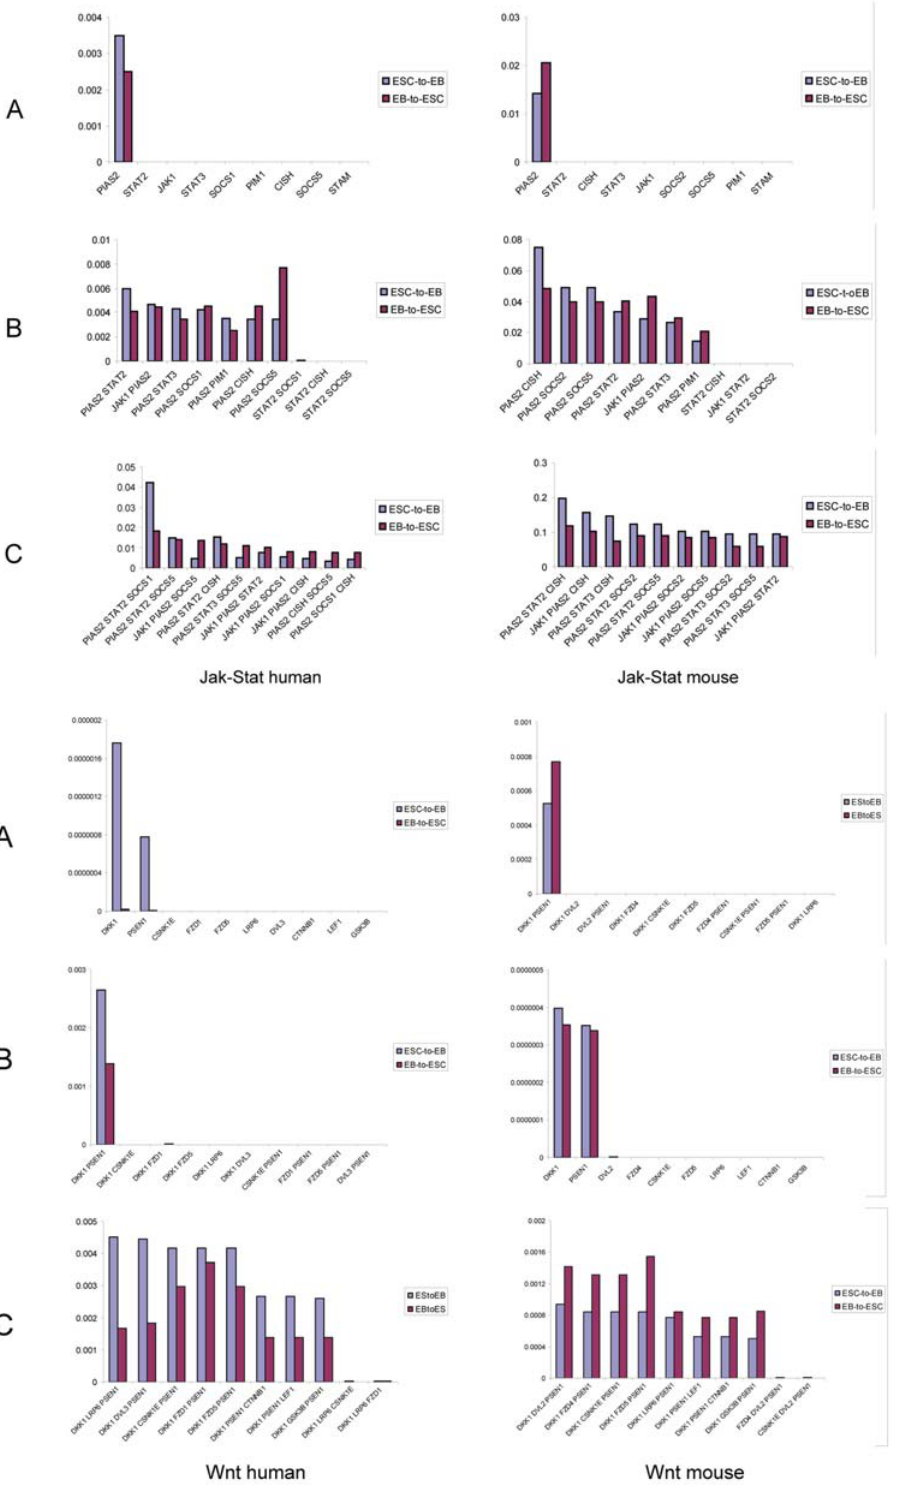
Figure 3. Probabilities of pathway behavior transition between ESC and EB states in response to transcriptional intervention on all individual genes (A), top 10 double-gene combinations (B), and top 10 triple-gene combinations (C) in JAK/STAT and WNT pathways of human and mouse. Each of the genes and gene combinations is listed for the maximum transition probability.